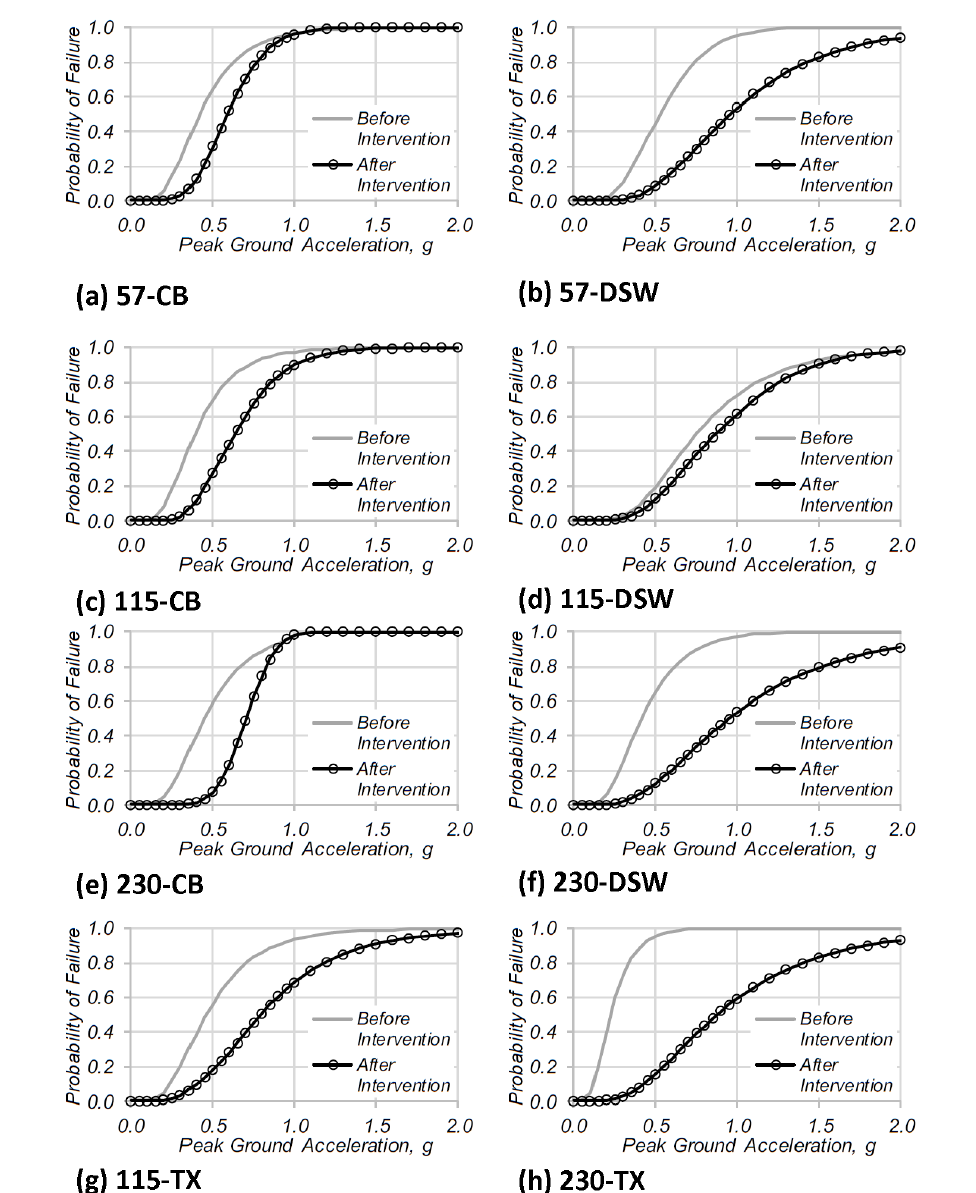
Figure 9. Comparison of initial (before intervention) and after upgrade (after intervention) fragility curves for 8 different types of